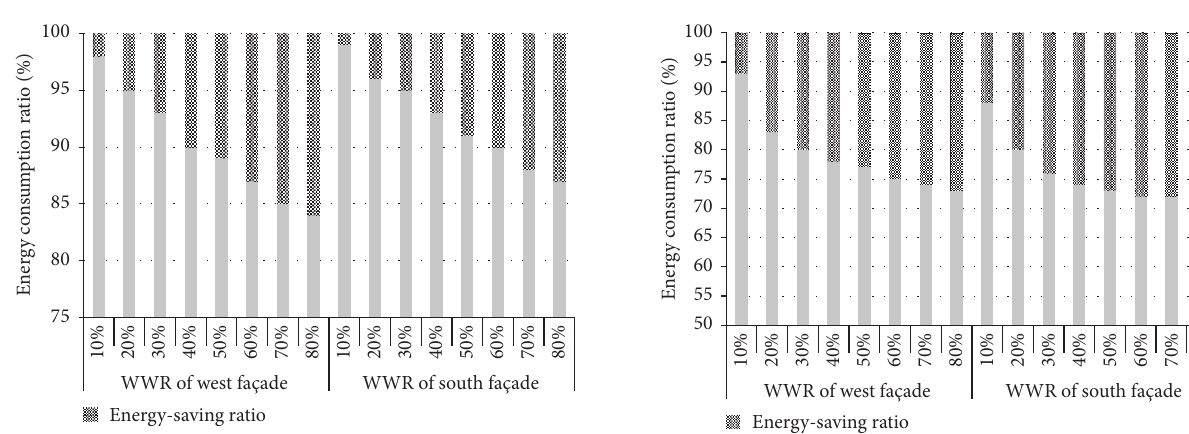
Figure 8: Energy consumption saving rate by installation of hori- zontal shading device and lighting control (Case